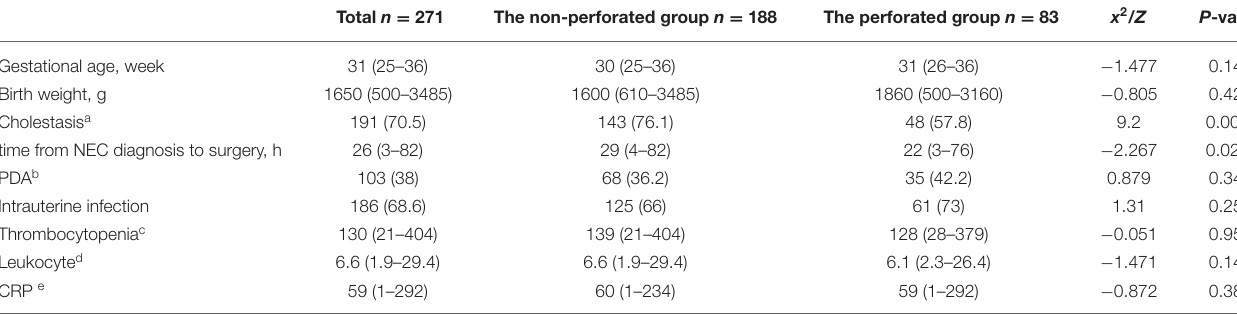
TABLE 1 | Comparison of preoperative factors in the non-perforated and the perforated groups [n (%), M (min, max)]. Total n = 271 The non-perforated group n = 188